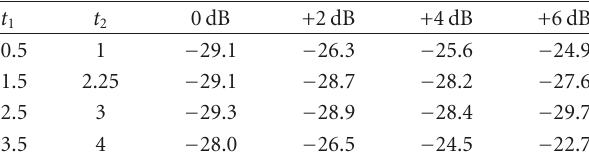
Table 1: Peak signal level in the bleed regions identified by t 1 and t 2 for a range of relative bleed